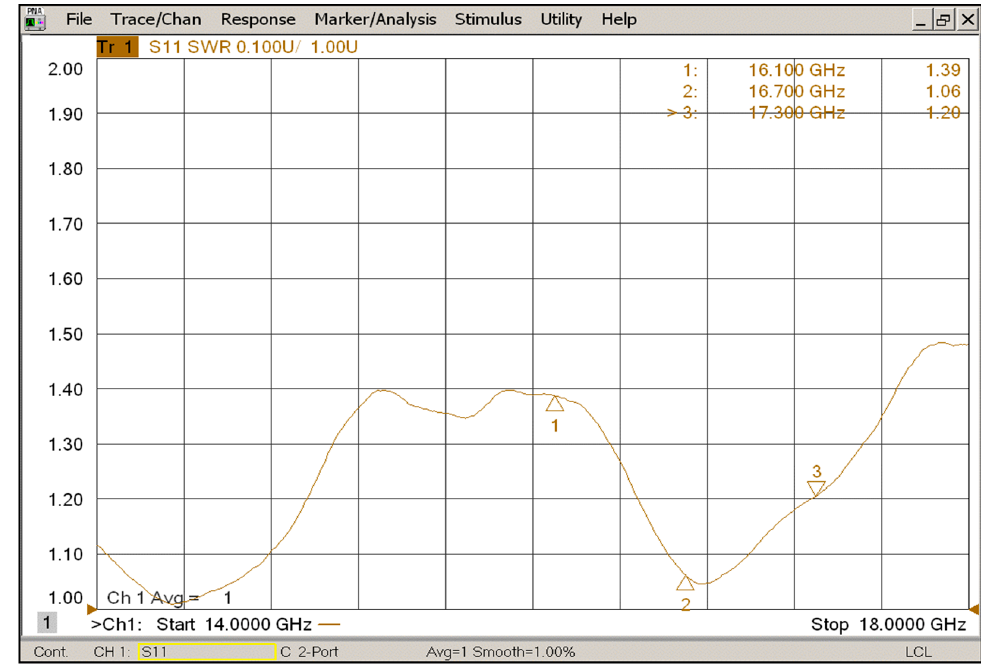
Figure 9. Measured SWR of the receive input port.